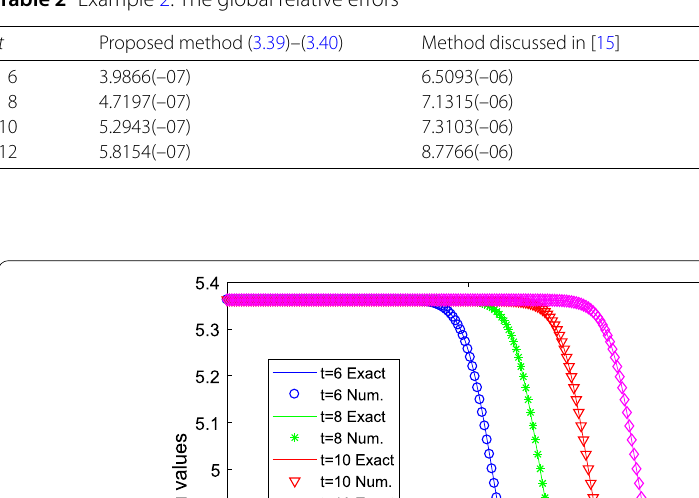
Table 2 Example 2: The global relative errors